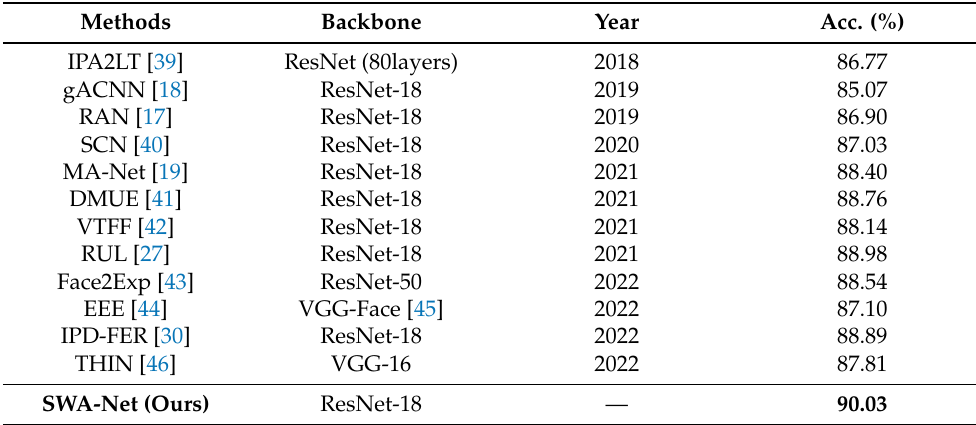
Table 6. Comparisons with the state-of-the-art methods on the RAF-DB dataset.